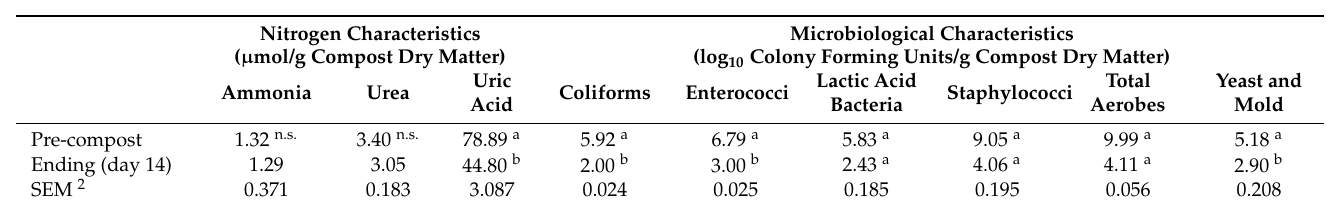
Table 3. Main effect means of day of composting in Experiment 2 on concentrations of nitrogen and select microbiological populations after 14 days of simulated composting of wood chip poultry litter 1